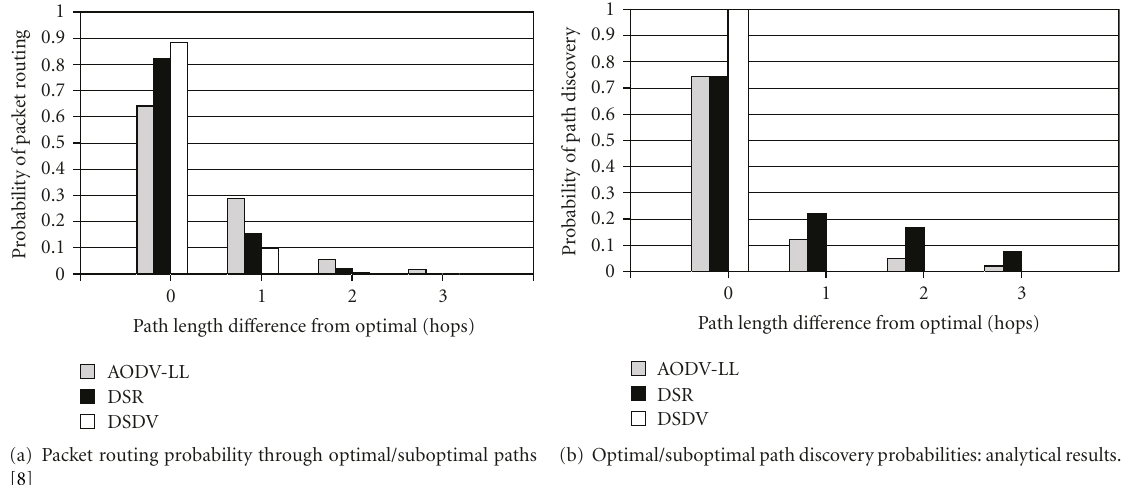
Figure 3: A comparison of route optimality models with simulation